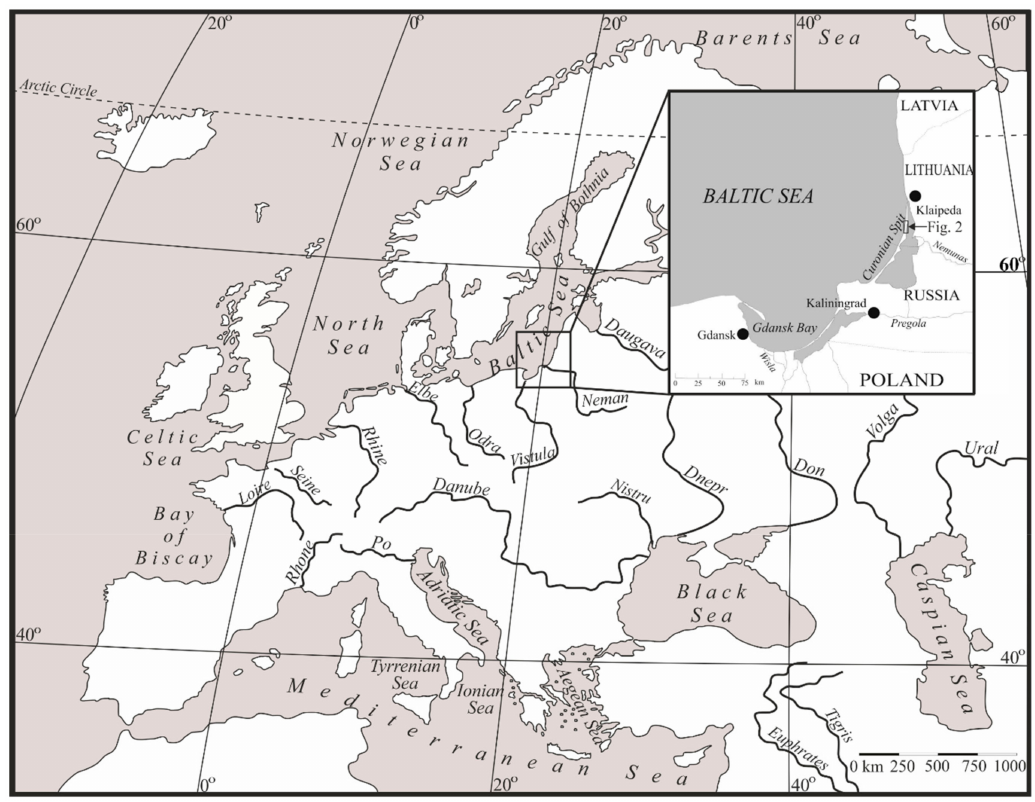
Figure 1. Location of the Curonian Spit on the southeast Baltic Sea